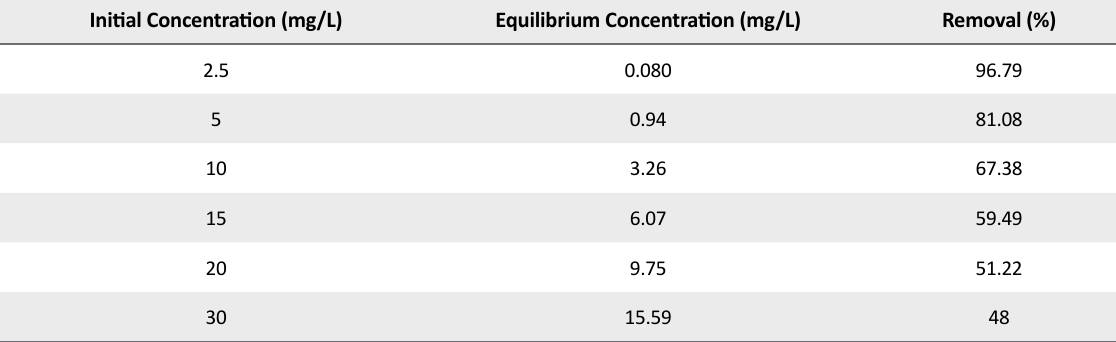
Table 1. Percentage of methyl orange dye output based on initial concentration changes Initial Concentration (mg/L)